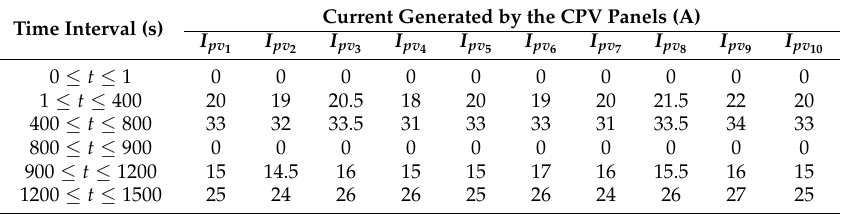
Table 2. Current generated by the concentration photovoltaic (CPV) panels throughout the time of the